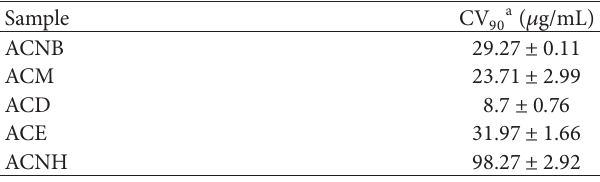
Table 1: The cell viability of Artocarpus communis